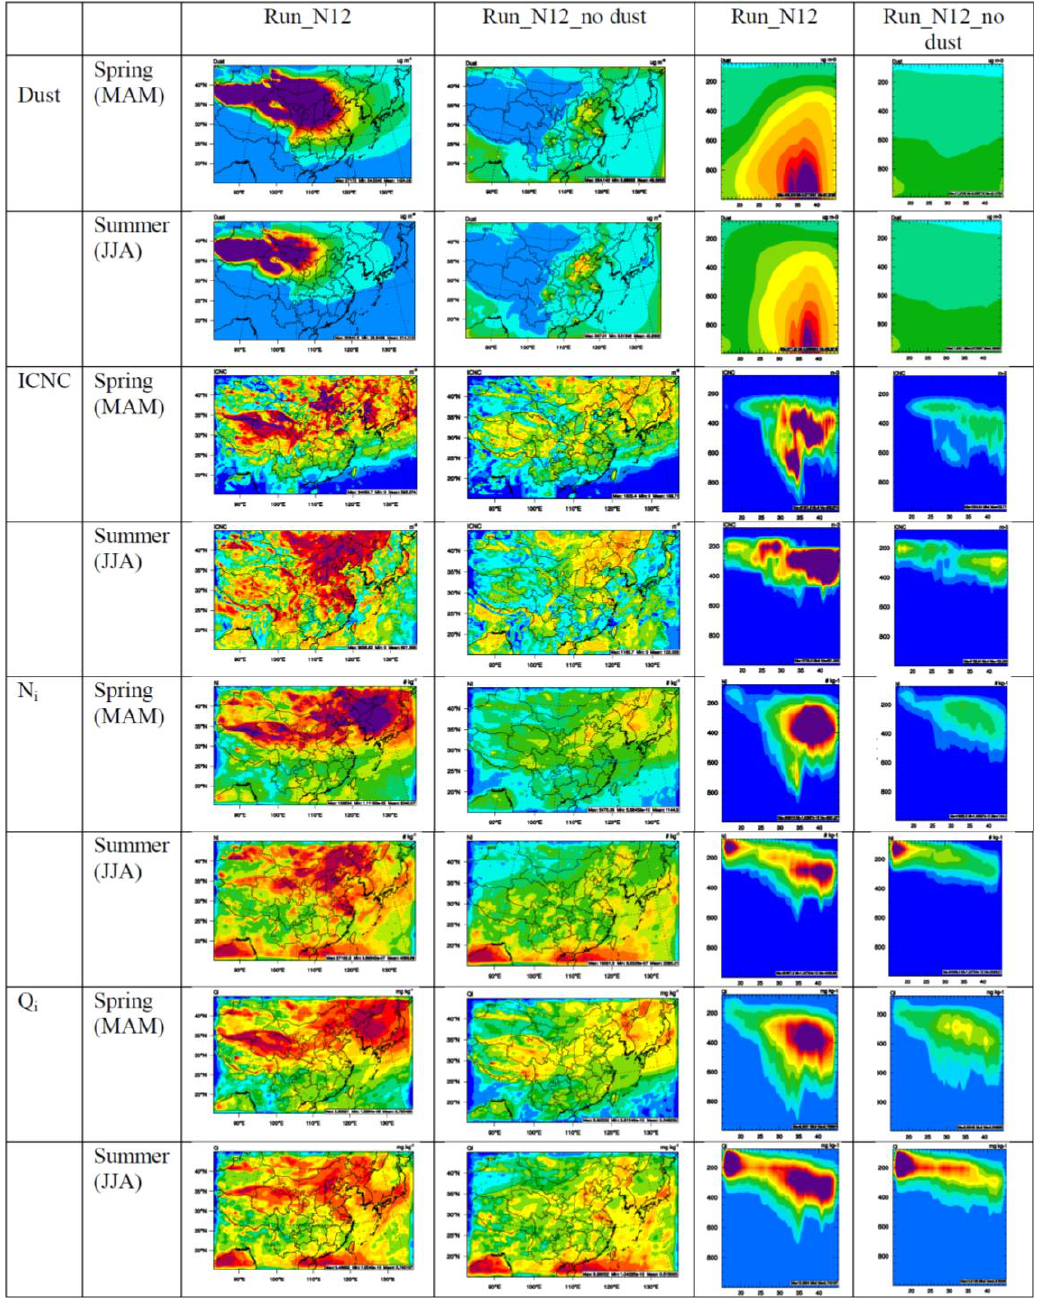
Figure 8. Spatial and zonal mean distributions of dust, ICNC, N i , and Q i for Run_N12 (with Z03 dust emission scheme) and Run_N12_no dust (without natural dust emissions)